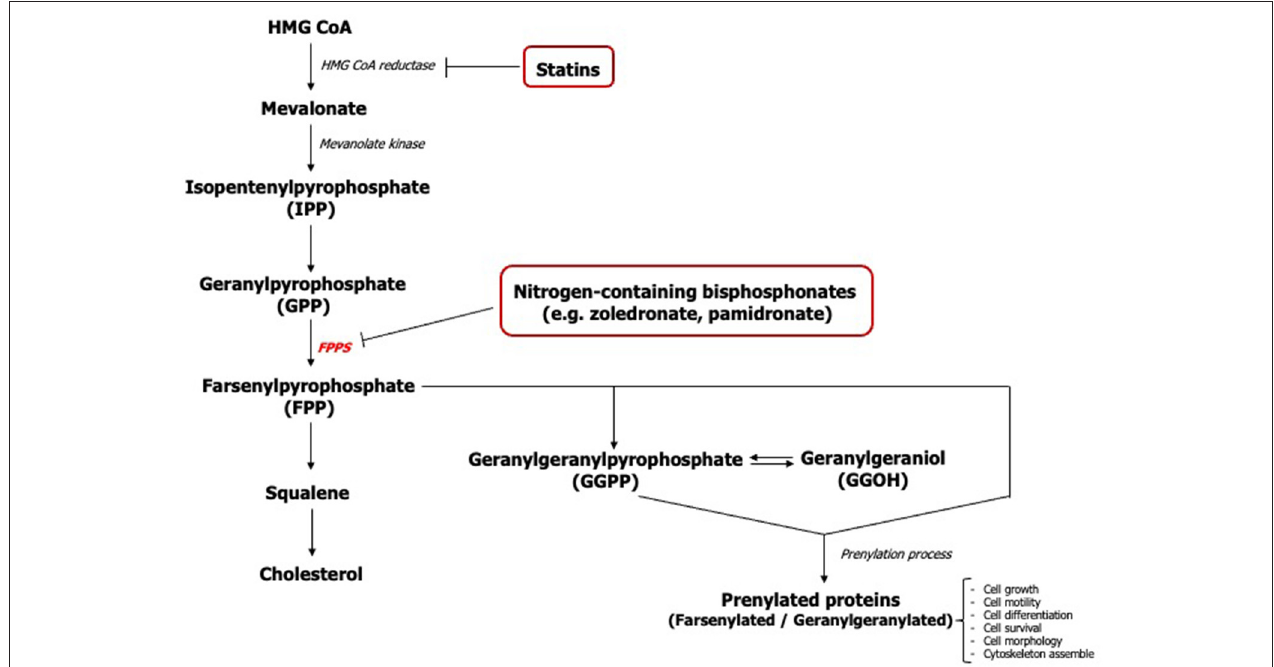
FIGURE 1 | The mevalonate pathway - FPPS (Farsenylpyrophosphate